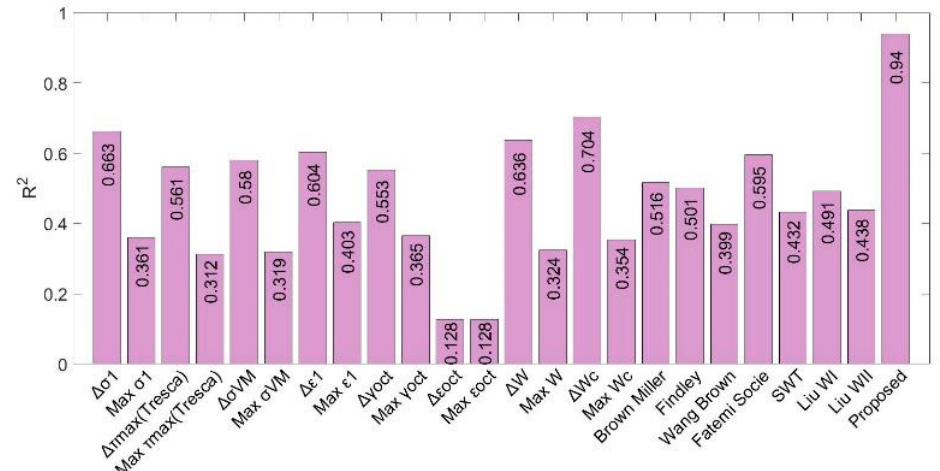
Figure 17. R 2 correlation parameter for each fatigue parameter used for SBR tests.